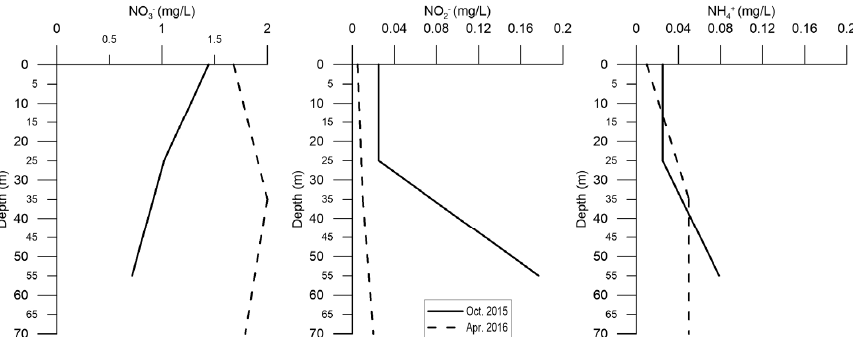
Figure 9. NO 2 − , NO 3 − , and NH 4+ (mg/L) profiles along the water column in October 2015 and April 2016.